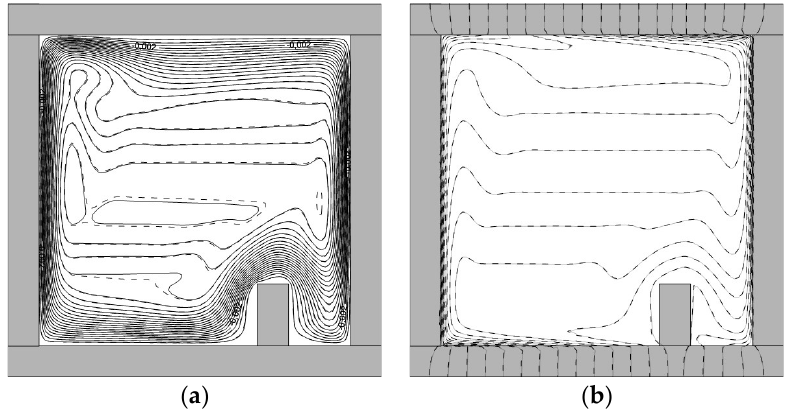
Figure 5. Isolines of stream function Ψ ( a ) and temperature Θ ( b ) at Ra = 10 9 , Pr = 0.7, λ w,air = 10000, h/L = 0.2: (cid:101) ε = 0—dashed lines, (cid:101) ε = 0.9 —solid